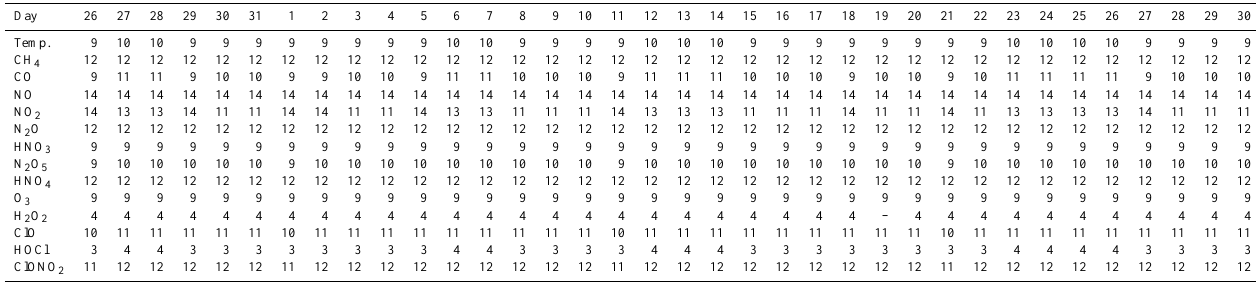
Table 1. Used MIPAS data versions (indicated by the last digits of the retrieval version) for all species on a daily basis within the period 26 October–30 November 2003. Day